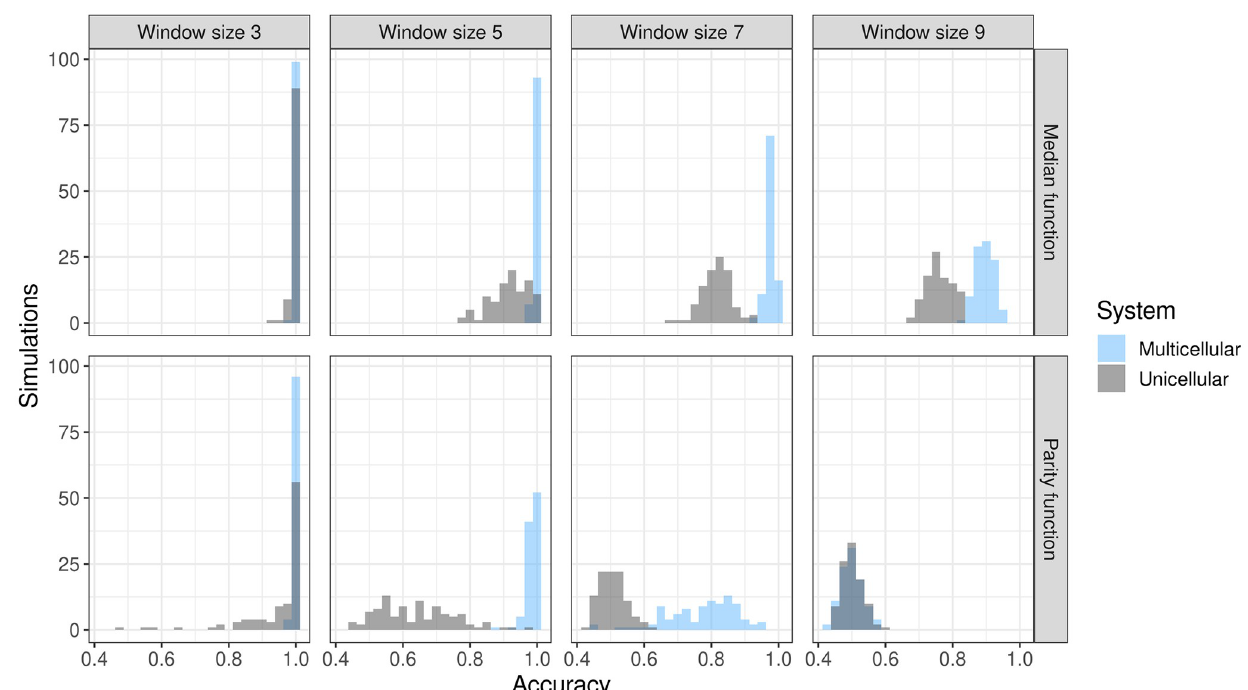
Fig 2. Simulation results from the Proof of Concept analysis. The distribution of reservoir accuracy is shown for median and parity functions with different function window sizes. To generate the distributions, each combination of window size and function was simulated 100 times. As parity is a harder function to approximate, the distributions are skewed towards the left compared to median function. For window size 3, both functions are well approximated, with almost all simulations performing with 100% accuracy. As window size increases, distributions move towards 50% (random chance) accuracy, with parity function reaching around 50% for window size 9 for both unicellular and multicellular systems. These results demonstrate that a community of cells can act as an RC and can outperform a single cell in that capacity.